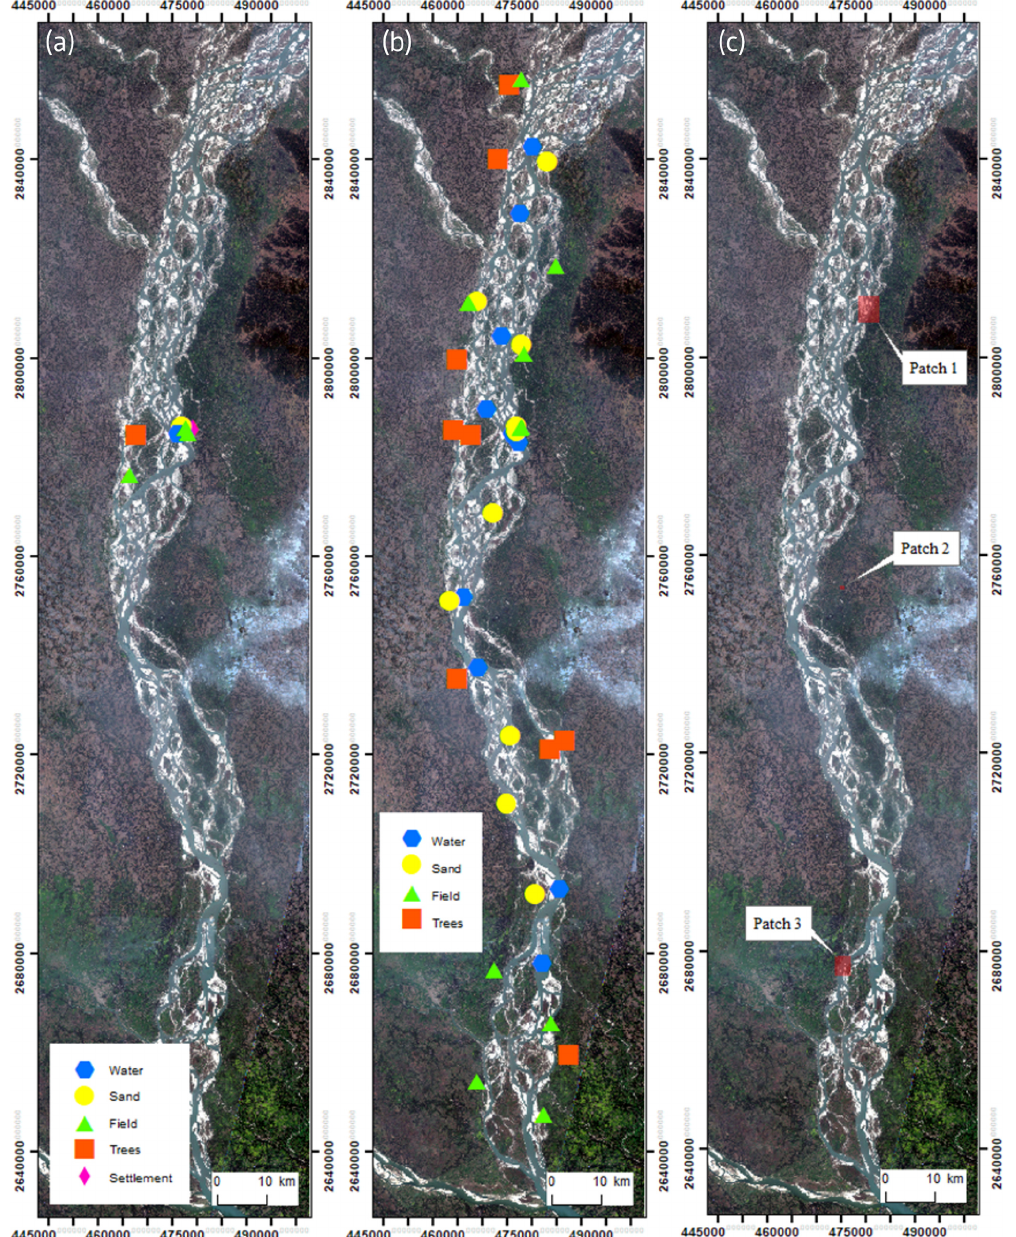
Figure A1. (a) Locations of the patches shown in Fig. 3 (symbols are larger than the patches). (b) Locations of the patches analyzed for the development of the land cover classification (symbols are larger than the patches). (c) Locations of the patches used to validate the land cover classification (patch 1), the settlement detection (patch 2) and the erosion detection (patch 3). Exact coordinates for all patches are contained in the GEE source code. Source of optical background image: